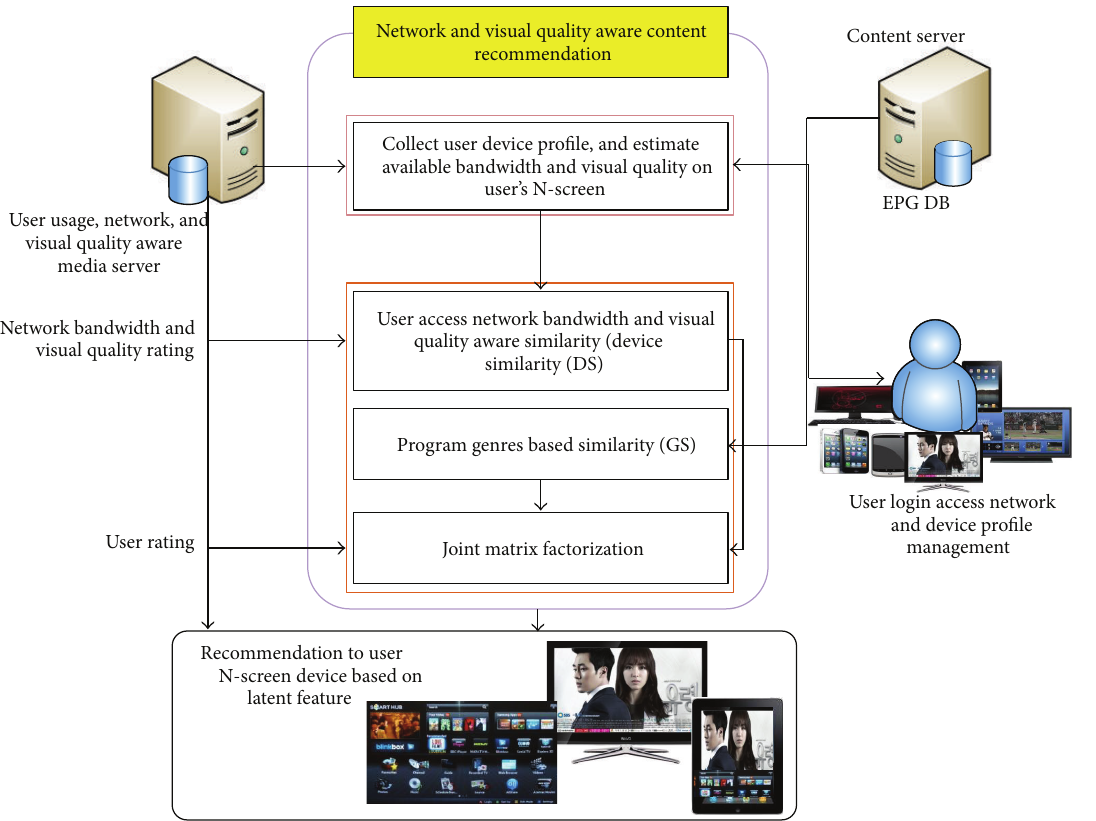
Figure 2: Architecture of proposed network and visual quality aware N-Screen content recommender